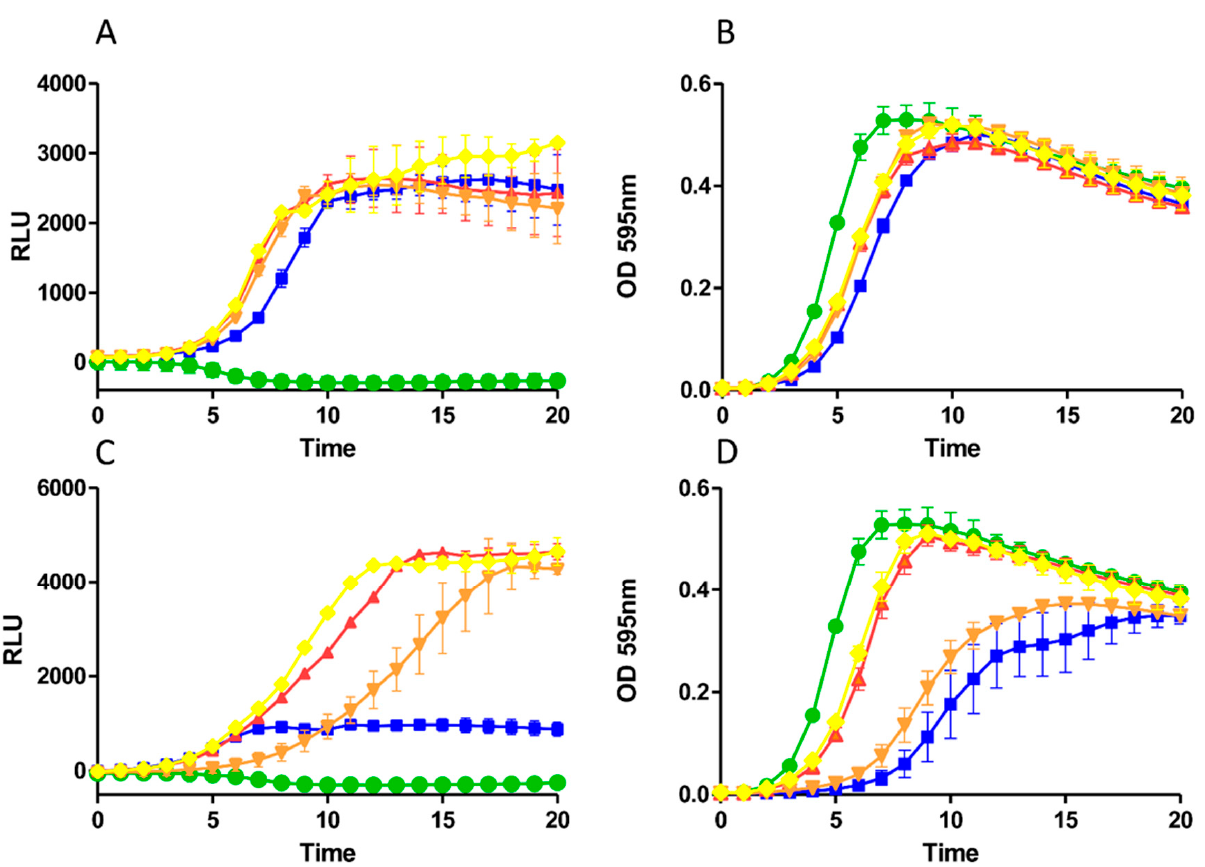
Figure 4. Comparison of induction capacities of nisin A (blue square), nisin A M17Q (orange triangle), nisin A HTK (red triangle), nisin T2L (yellow diamond) and untreated control (green circle) as determined by expression of GFP under the control of the P nisA promoter in L. lactis NZ9000 pNZ8150 gfp+ induced at final concentrations of ( A ) 10 ng/mL and ( C ) 30 ng/mL and the effects on growth of L. lactis NZ9000 pNZ815 0gfp+ induced at concentrations of ( B ) 10 ng/mL and ( D ) 30 ng/mL as determined by absorbance at OD 595nm.